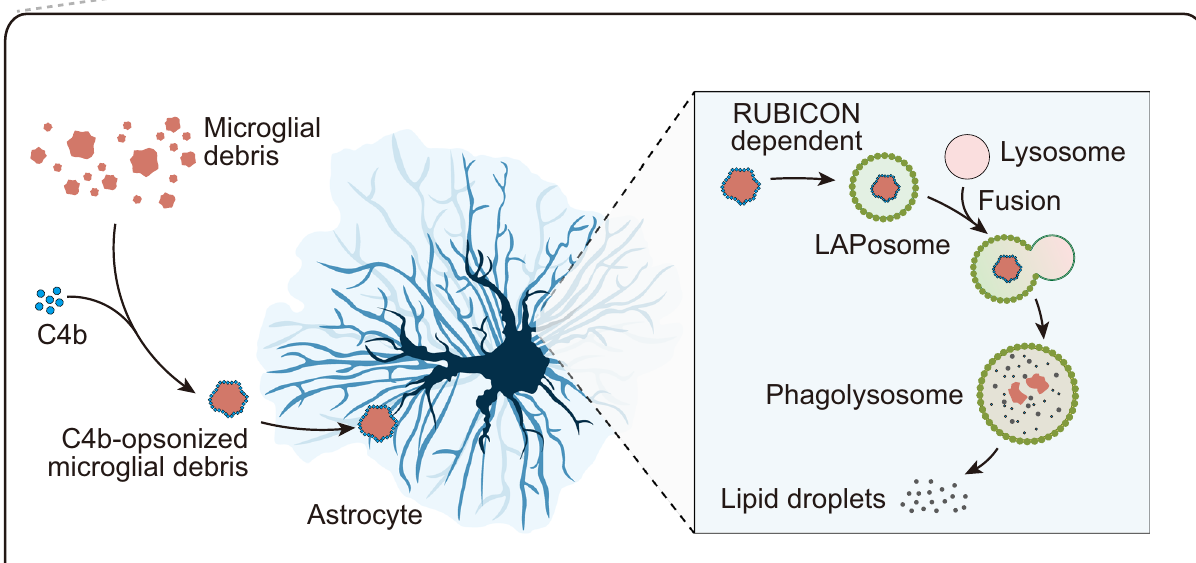
The phagocytosed debris is then degraded in astrocytes via RUBICON-dependent LAP, and microglial debris-containing LAPosomes subsequently fuse with lyso- somes to form phagolysosomes, in which the debris is